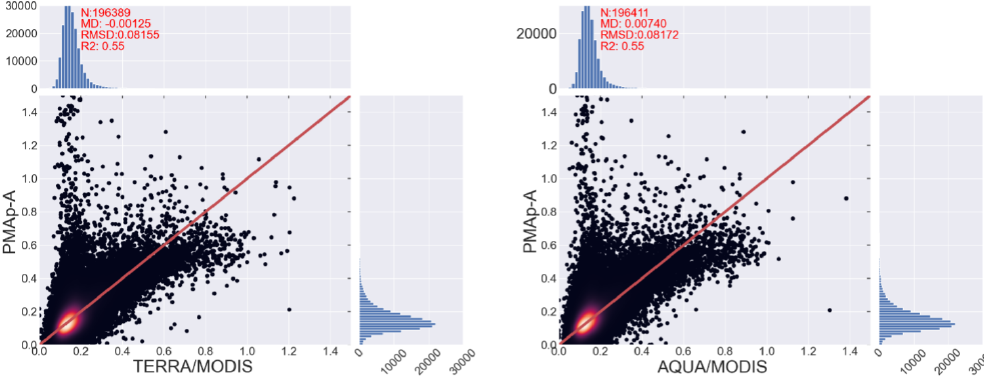
Figure B4. PMAp-A vs. MODIS AOD scatter plots of temporal mean AOD over ocean for the DJF period.